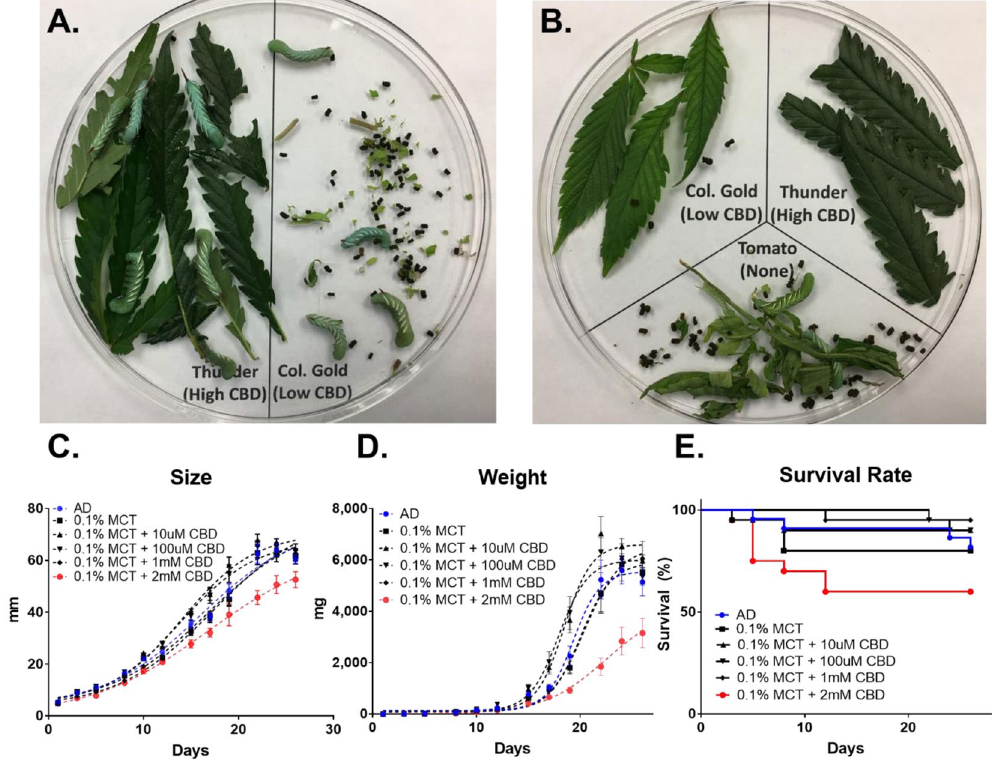
Figure 1. CBD as a potent feeding deterrent for M . sexta . ( A ) Two-way feeding preference test on the high CBD (3.2%) - and low CBD (0.81%)-producing C . sativa leaves. ( B ) Three-way feeding test with Solanum lycopersicum leaves. The size ( C ), weight ( D ), and mortality ( E ) of M . sexta when fed on AD containing 10 μ M, 100 μ M, 1 mM, and 2 mM CBD. For statistical analyses on insect growth and survival rate, a one-way ANOVA with Tukey’s multiple comparisons test (n = 20~22, p < 0.05) and Mantel-Cox test (n = 20~22, p < 0.05) were used,